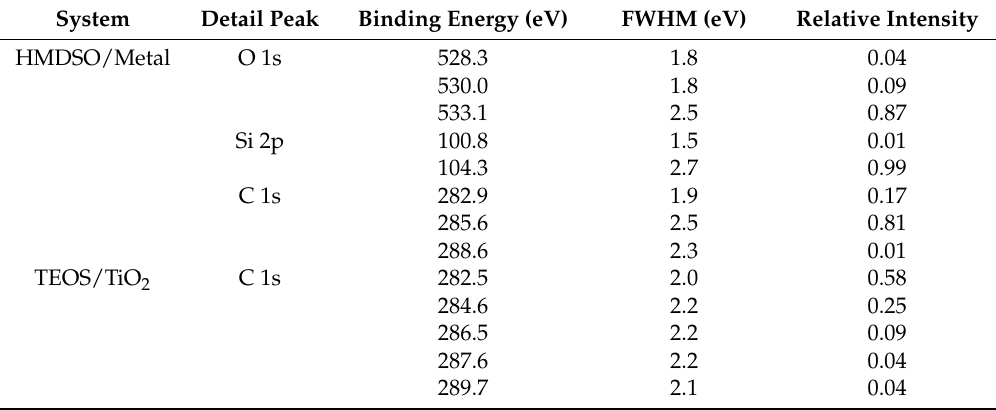
Table 2. Summarized XPS results from Pt metal particles coated with HMDSO and from the C 1s from TEOS-coated titania. System Detail